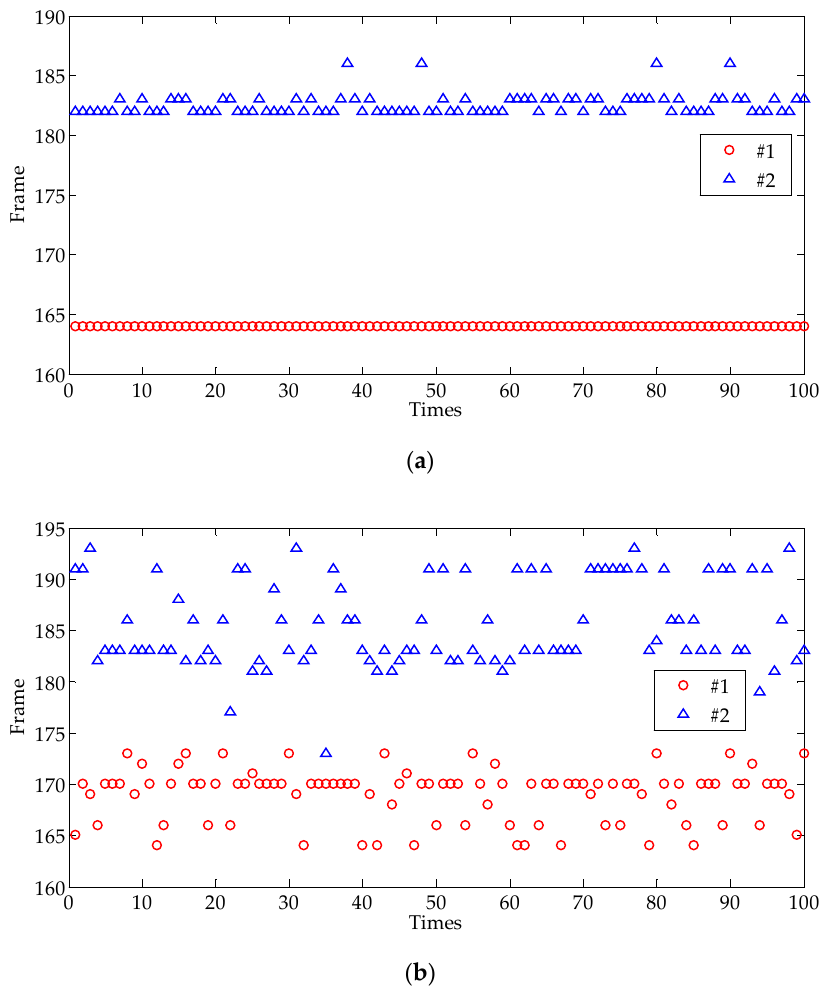
Figure 20. The scatter diagram of the experiment conducted 100 times: ( a ) The scatter diagram of the experiment conducted 100 times by uniform selection; ( b ) The scatter diagram of the experiment conducted 100 times by random selection.